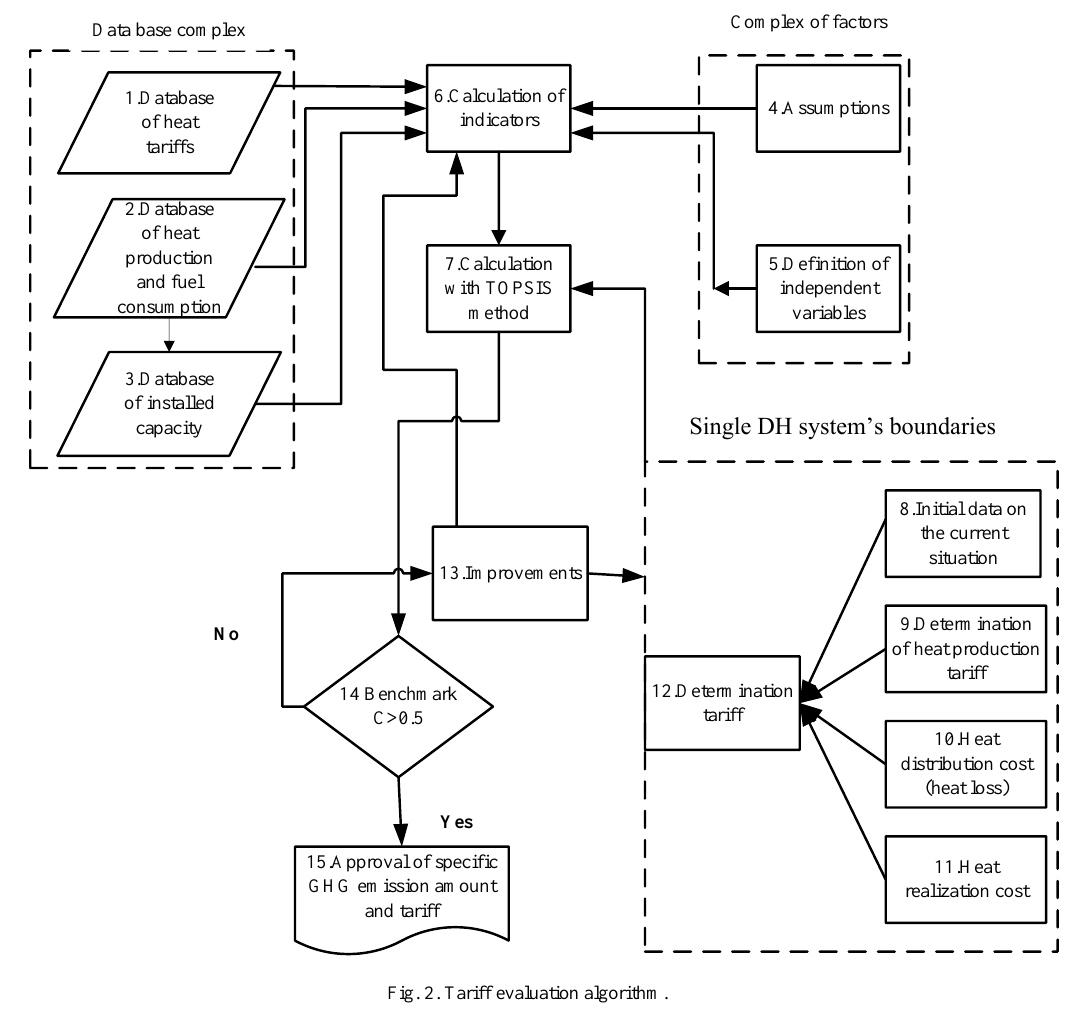
Fig. 2. Tariff evaluation